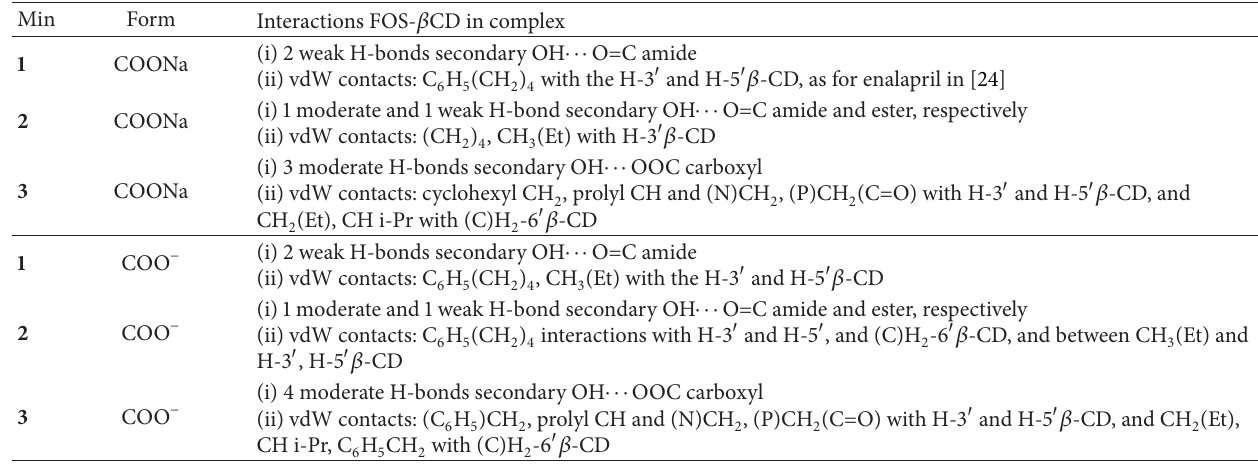
Table 3: Hydrogen bonds and the most important van der Waals interactions between FOS and 𝛽 -CD, for each complex type, as resulting from PM3